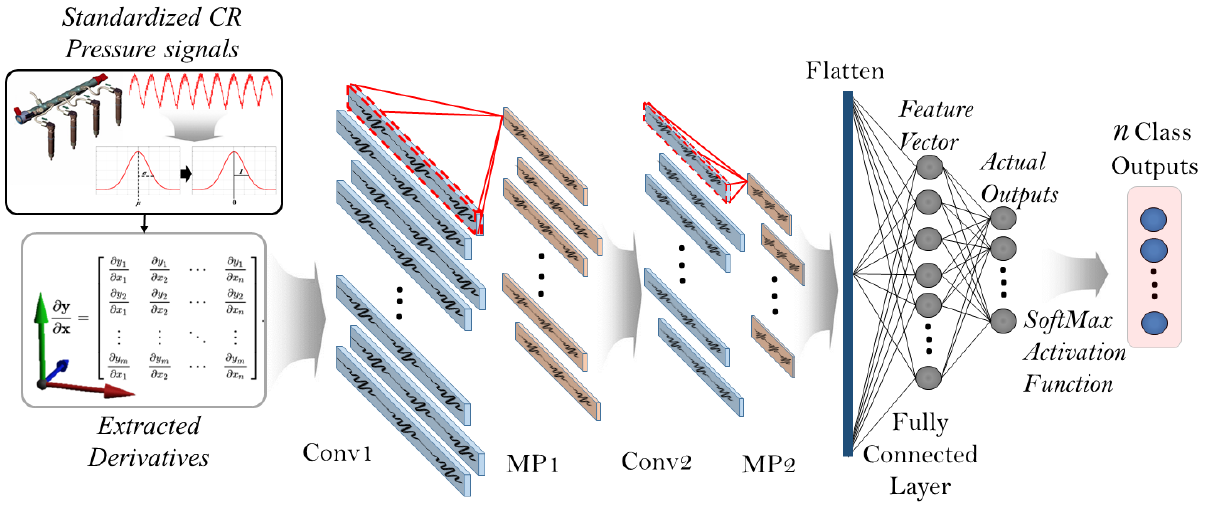
Figure 3. Proposed 1D-CNN-based condition monitoring